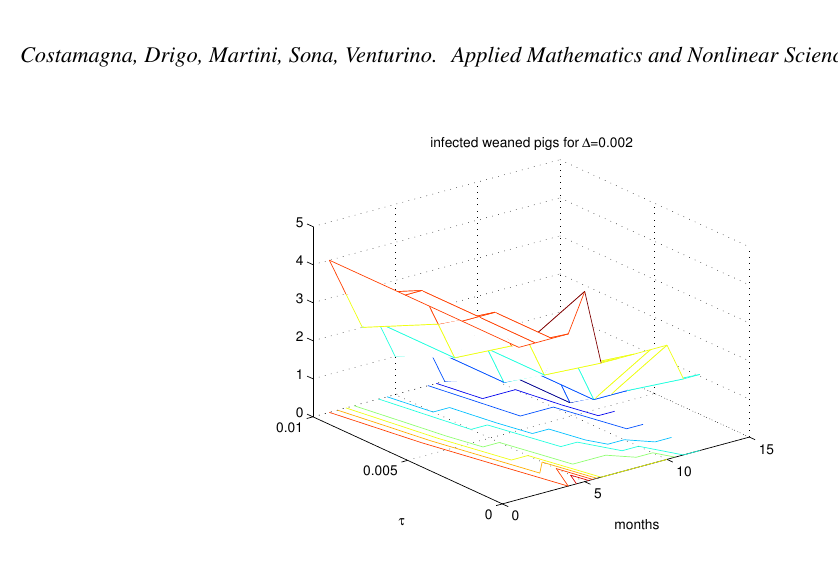
Fig. 7 Infected weaned pigs evolution during a whole year. Here we fix the value of biohazard rate at ∆ = 0 . 002.